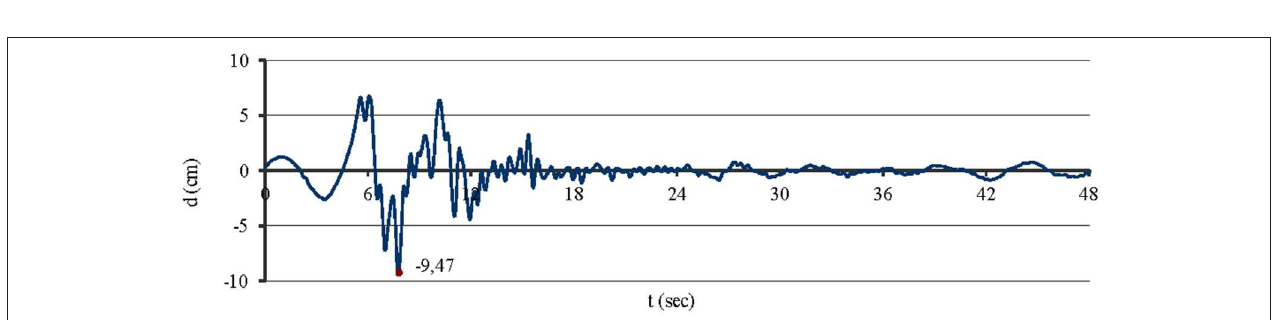
FIGURE 10 | N–S component of the Montenegro earthquake of 15.04.1979 and the Petrovac record (Stavroulaki and Amanatidou, 2008).